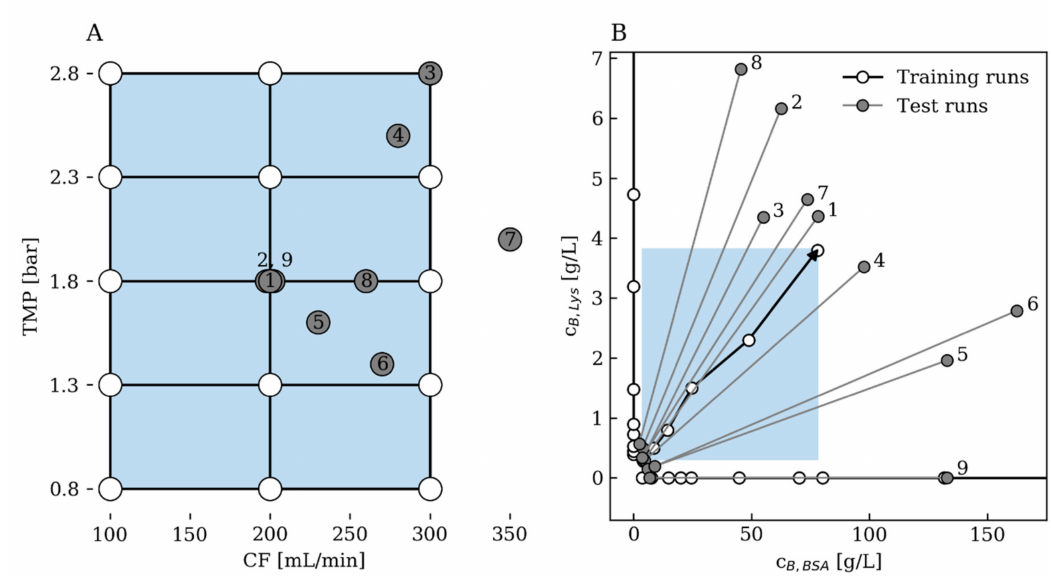
Figure 5. Schematic depiction of the training space (blue area) for: ( A ) TMP and CF of training runs (white dots) and test runs (grey dots); ( B ) initial to final c B,BSA and c B,Lys of the test runs (grey dots with grey solid lines) and the covered concentration range of the three training runs (white dots with black solid